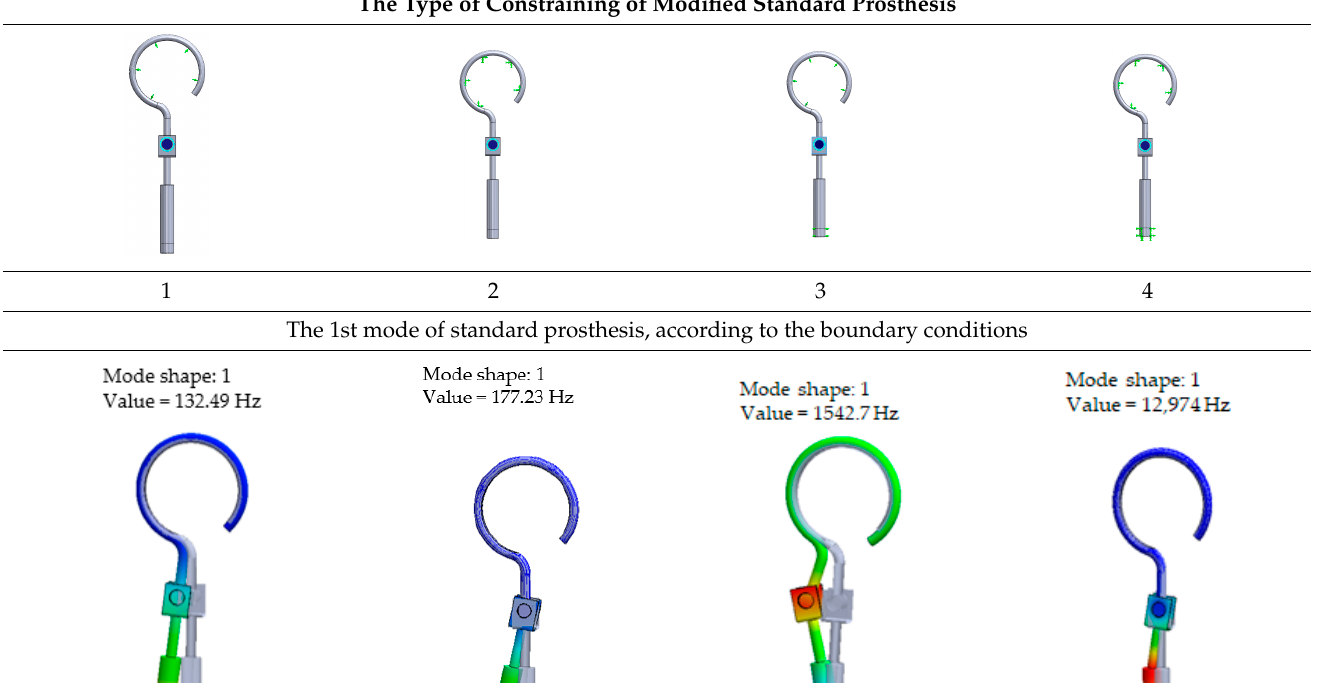
Table 3. The results of eigenfrequency analysis of modified standard prosthesis: the 1st mode and the eigenfrequencies (Hz) of first 4 modes.